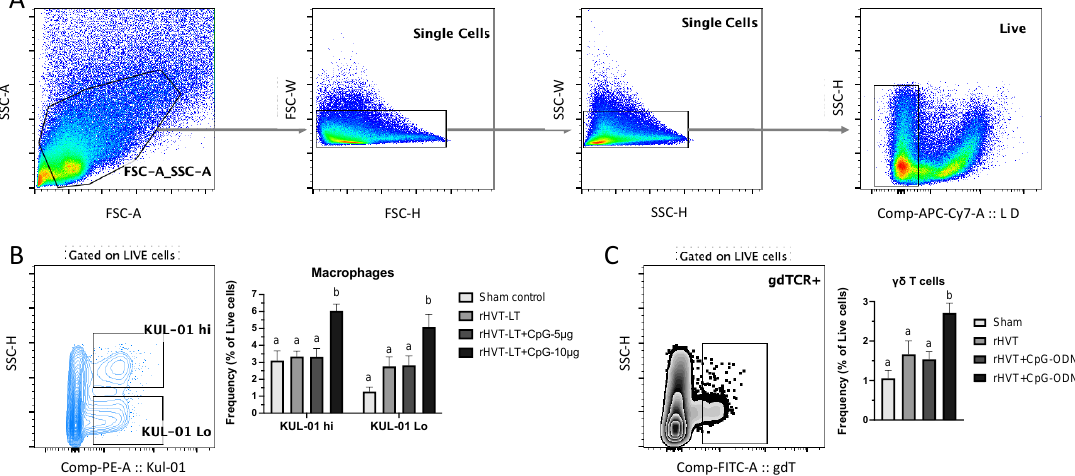
Figure 4. Effect of CpG-ODN on macrophage responses in one-day-old chicks. Single-cell splenocyte suspensions were prepared to obtain mononuclear cells and stained with anti-chicken monoclonal antibodies against KUL-01 (macrophage/monocyte lineage marker) and TCR γδ receptor. ( A ) Basic gating strategy showing representative analysis plots to exclude doublets from the populations and gating on live cells. ( B ) Live cells were gated to obtain macrophage populations and representative plot showing KUL-01 hi and KUL-01 Lo cells along with the bar chart depicting frequencies found across the treatment groups. ( C ) Live cells were gated to obtain TCR γδ + populations and representa- tive plot showing γδ T cells along with the bar chart depicting frequencies found across the treatment groups. Different letters above the standard-error-of-mean bars within each of the data set graphs indicate significant statistical difference ( p < 0.05) between the